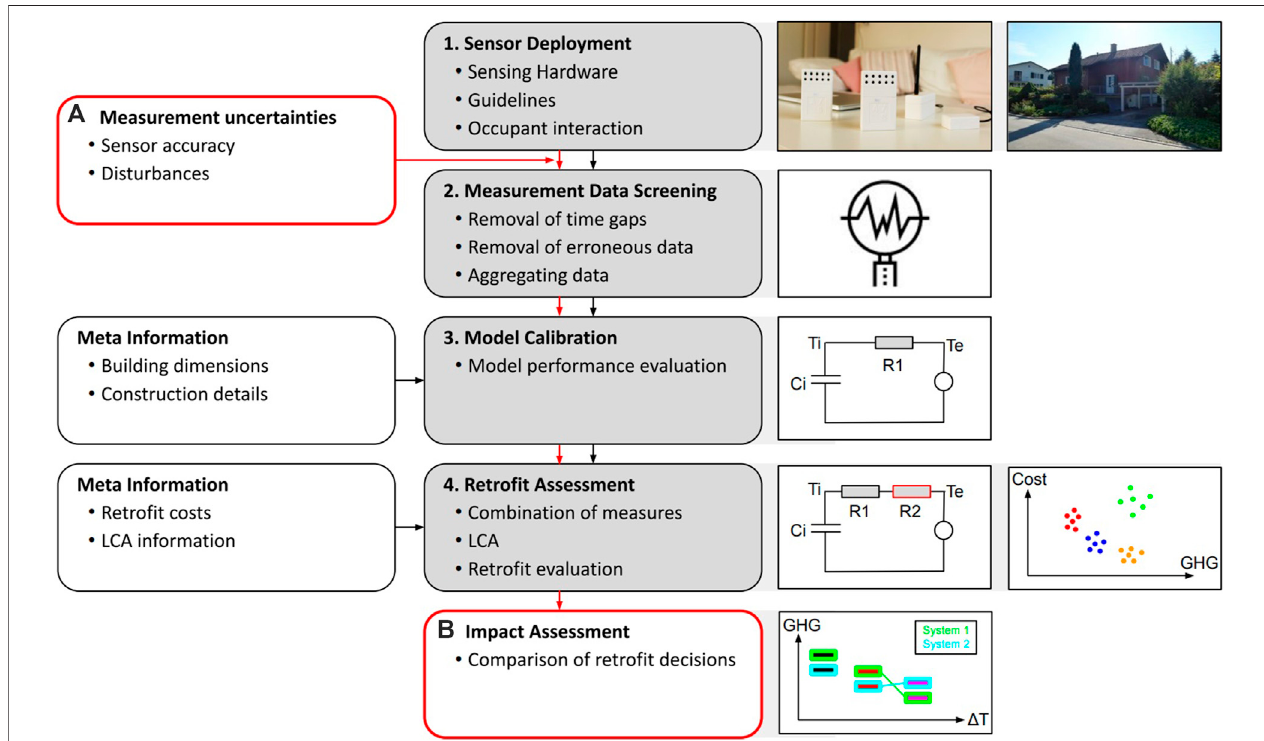
FIGURE 1 | Process of measurement uncertainty impact assessment (red frame) based on the evidence-based retro fi t process (black frame).